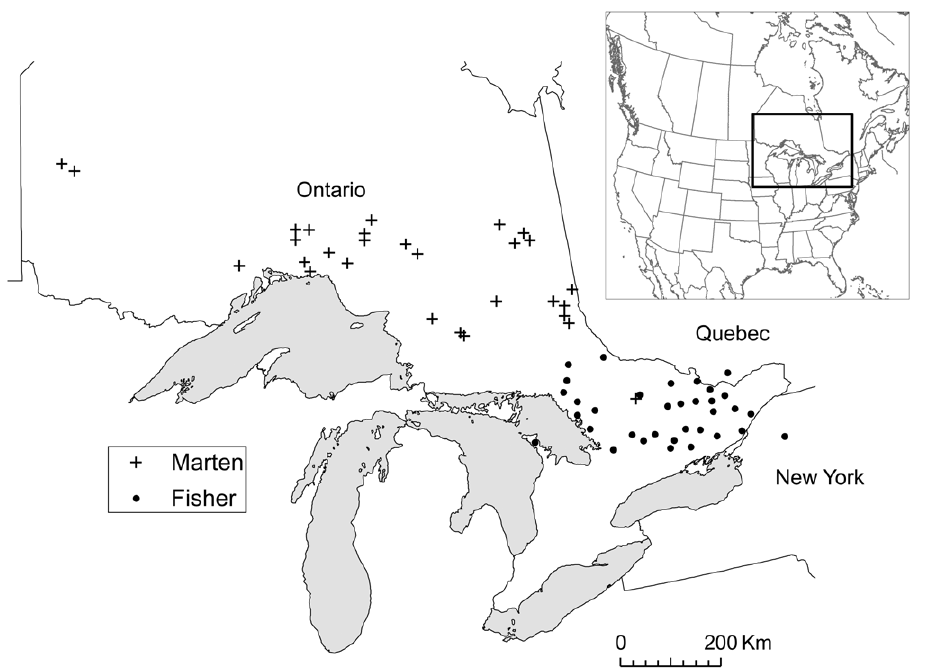
Figure 1. Locations of American marten ( Martesamericana ; n=29) and fisher ( M.pennanti ; n=34) sampling sites. Inset shows location of Ontario and Quebec, Canada, and New York, USA, within central North America.